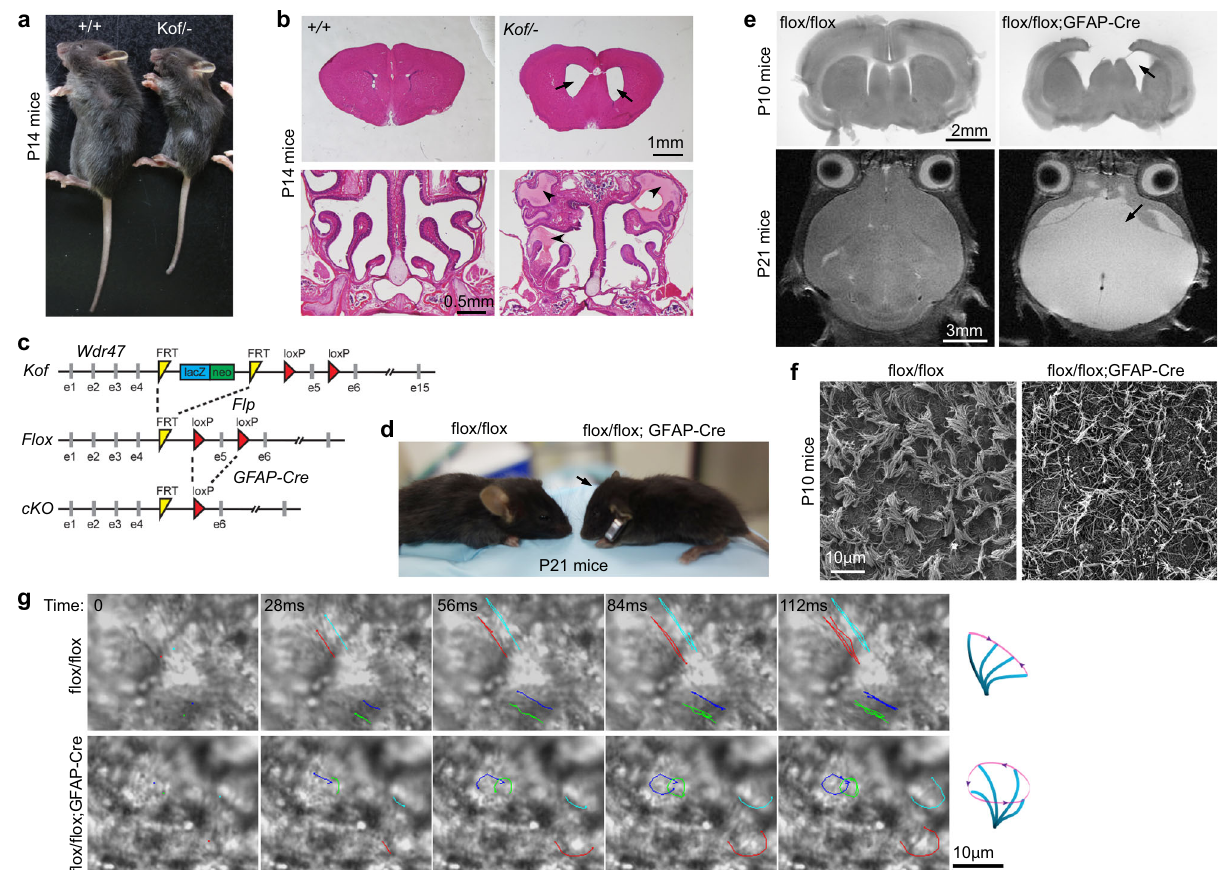
Fig. 3 Wdr47 de fi ciency in multicilia results in hydrocephalus and chronic sinusitis. a Representative littermates of Wdr47 Kof/ − and wild-type mice. b Wdr47 Kof/ − mice displayed both hydrocephalus and chronic sinusitis ( n = 3 biological replicates). Shown are representative HE-stained coronal sections of the brain and the paranasal cavity. Arrows and arrowheads indicate enlarged ventricles and accumulated mucus, respectively. c Strategies for generating Wdr47 fl ox/ fl ox ; GFAP - Cre conditional knockout (cKO) mice to knockout Wdr47 in progenitors of mEPCs. Wdr47 Kof/ + mice were crossed with Flp mice to produce Wdr47 fl ox/ + mice, which were then crossed with GFAP-Cre mice to produce Wdr47 fl ox/ + ; GFAP - Cre mice. d The Wdr47 cKO mice displayed a dome-shaped skull (arrow) ( n = 3 biological replicates). e The cKO mice displayed progressive hydrocephalus (arrows) as shown by coronal brain sections at P10 and transverse magnetic resonance images at P21. Experiment was performed once. f , g Multicilia in the Wdr47 fl ox/ + ; GFAP - Cre ependyma were disorganized under scanning EM and rotatory in live imaging, acquired at 140 frames per second (fps) using live brain slices of P10 mice. Scanning EM was performed twice. Live imaging was carried out once. Trajectories of four traceable cilia over time are shown on representative image